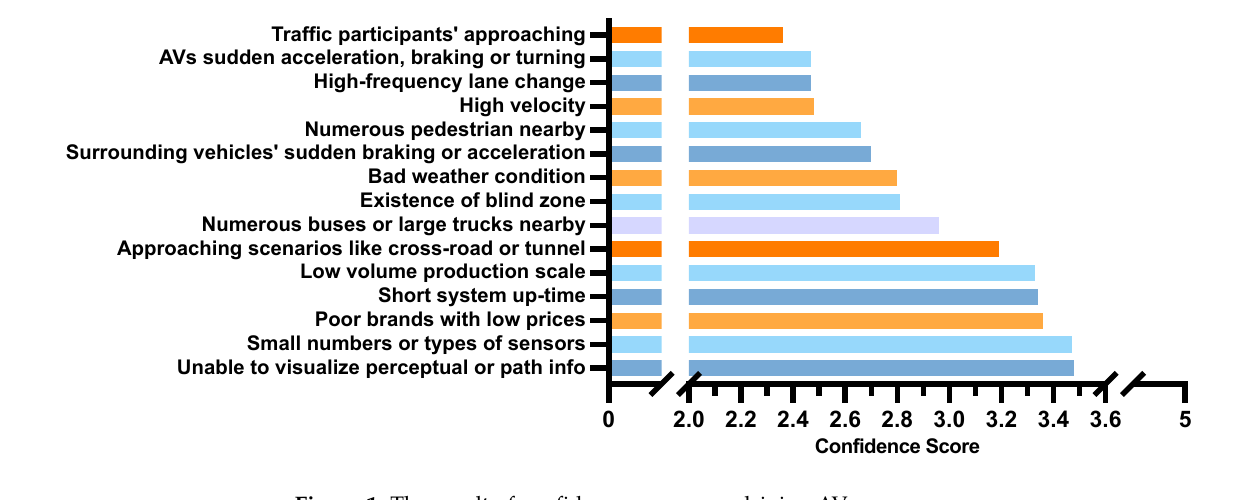
Figure 1. The result of confidence survey on driving